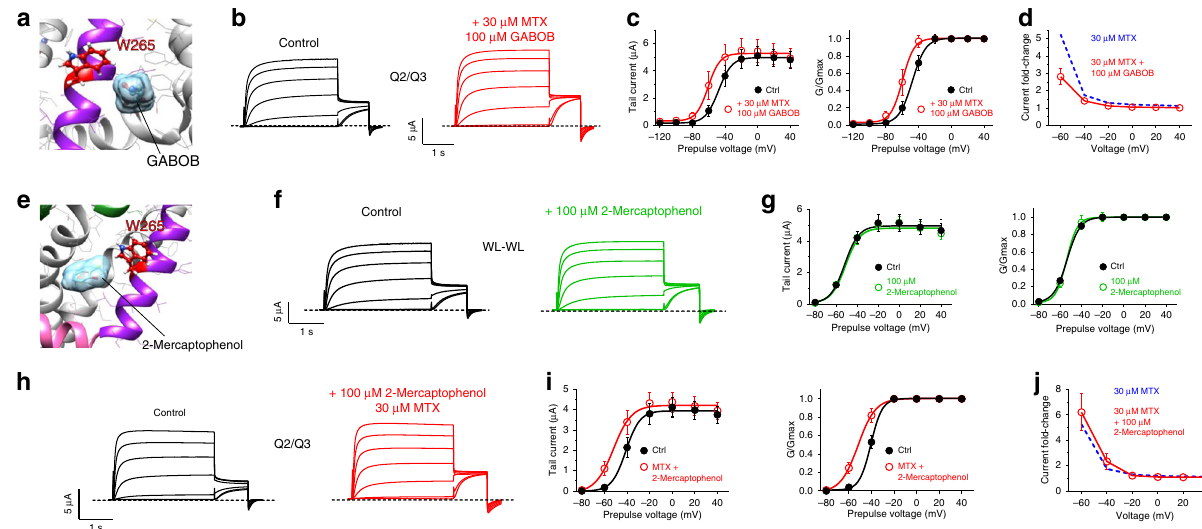
Fig. 4 MTX outcompetes 2-mercaptophenol to activate KCNQ2/3. a Binding position of GABOB predicted by SwissDock using a chimeric KCNQ1 – KCNQ3 structure model. b Exemplar traces showing effects of MTX (30 µ M) with GABOB (100 µ M) on KCNQ2/3 channels. Voltage protocol as in Fig. 1d. c Effects of MTX (30 µ M) with GABOB (100 µ M) on mean tail current ( left ) and G / G max ( right ) relationships for KCNQ2/3 ( n = 6) calculated from traces as in panel b . d Current fold-change at − 60 mV exerted by MTX (30 µ M) alone (from Fig. 2a) or with 100 µ M GABOB, from data as in panel c ( n = 6). e Binding position of 2-mercaptophenol predicted by SwissDock using a chimeric KCNQ1 – KCNQ3 structure model. f Exemplar traces showing effects of 2-mercaptophenol (100 µ M) on KCNQ2-W236L/KCNQ3-W265 (WL-WL) channels. Voltage protocol as in Fig. 1d. g Effects of 2- mercaptophenol (100 µ M) on mean tail current (left) and G / G max (right) relationships for KCNQ2-W236L/KCNQ3-W265 (WL-WL) channels ( n = 9) calculated from traces as in panel f . h Exemplar traces showing effects of MTX (30 µ M) with 2-mercaptophenol (100 µ M) on KCNQ2/3 channels. Voltage protocol as in Fig. 1d. i Effects of MTX (30 µ M) with 2-mercaptophenol (100 µ M) on mean tail current (left) and G / G max (right) relationships for KCNQ2/3 ( n = 9) calculated from traces as in panel h . j Current fold-change at − 60 mV exerted by MTX (30 µ M) alone (from Fig. 2a) or with 100 µ M 2- mercaptophenol, from data as in panel i ( n = 9). All error bars indicate